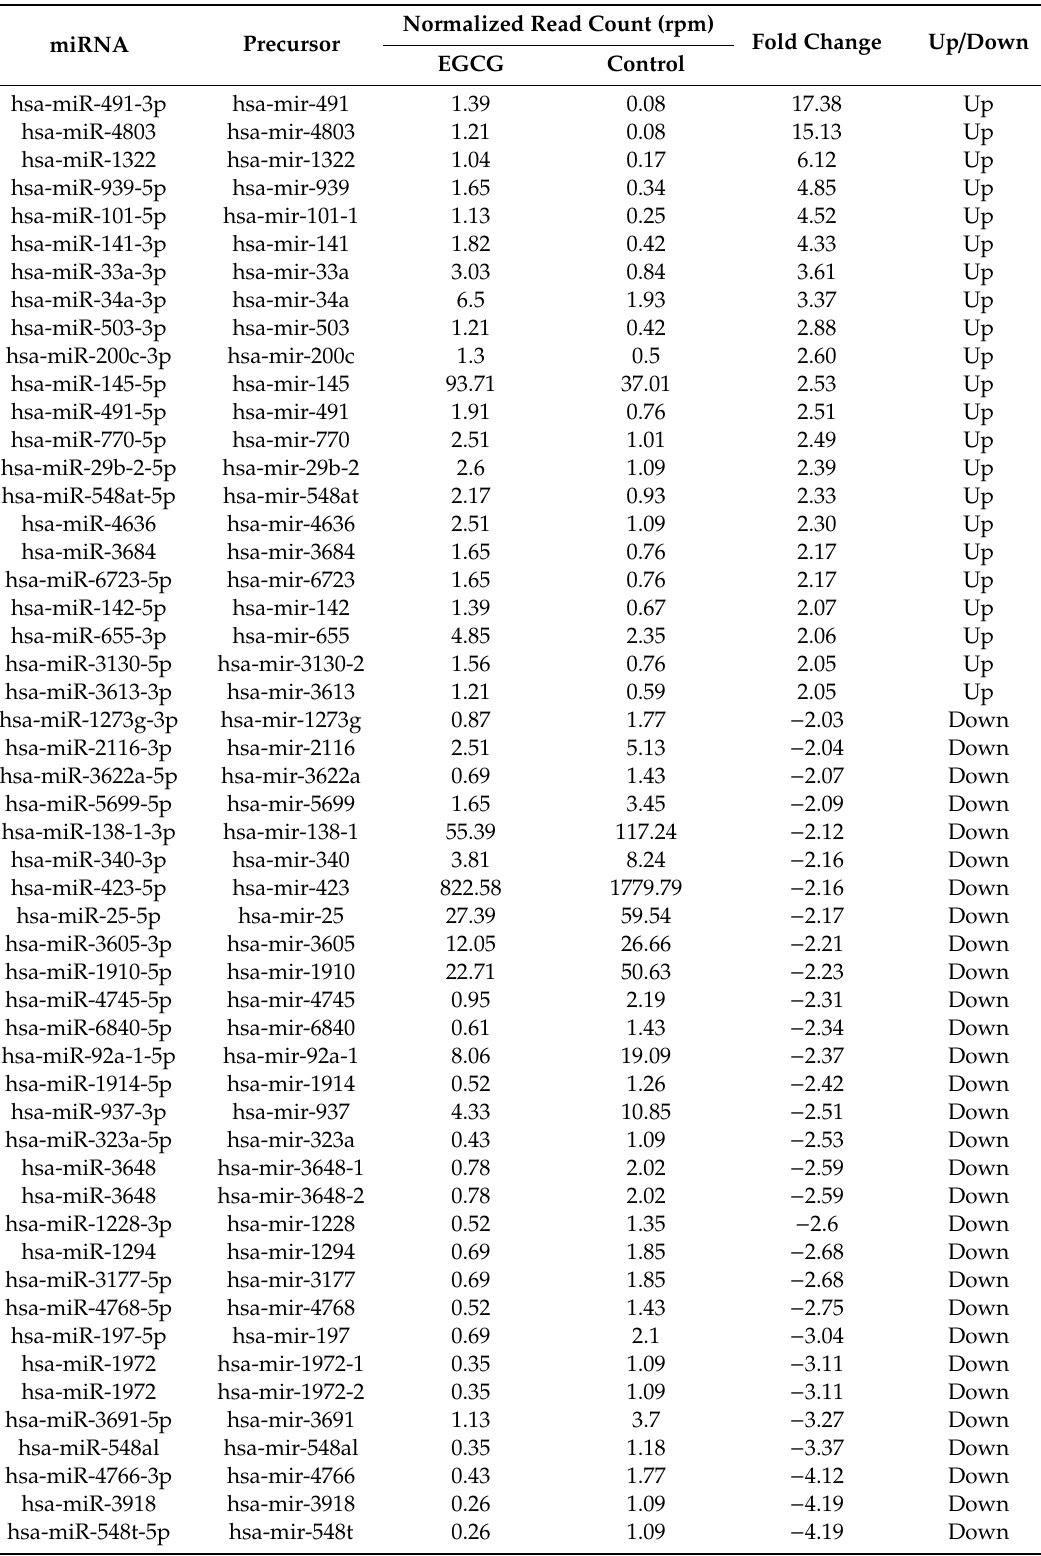
Table A2. MicroRNAs with significant change in idiopathic pulmonary fibrosis (IPF) fibroblasts treated with epigallocatechin gallate (EGCG) versus water (control).